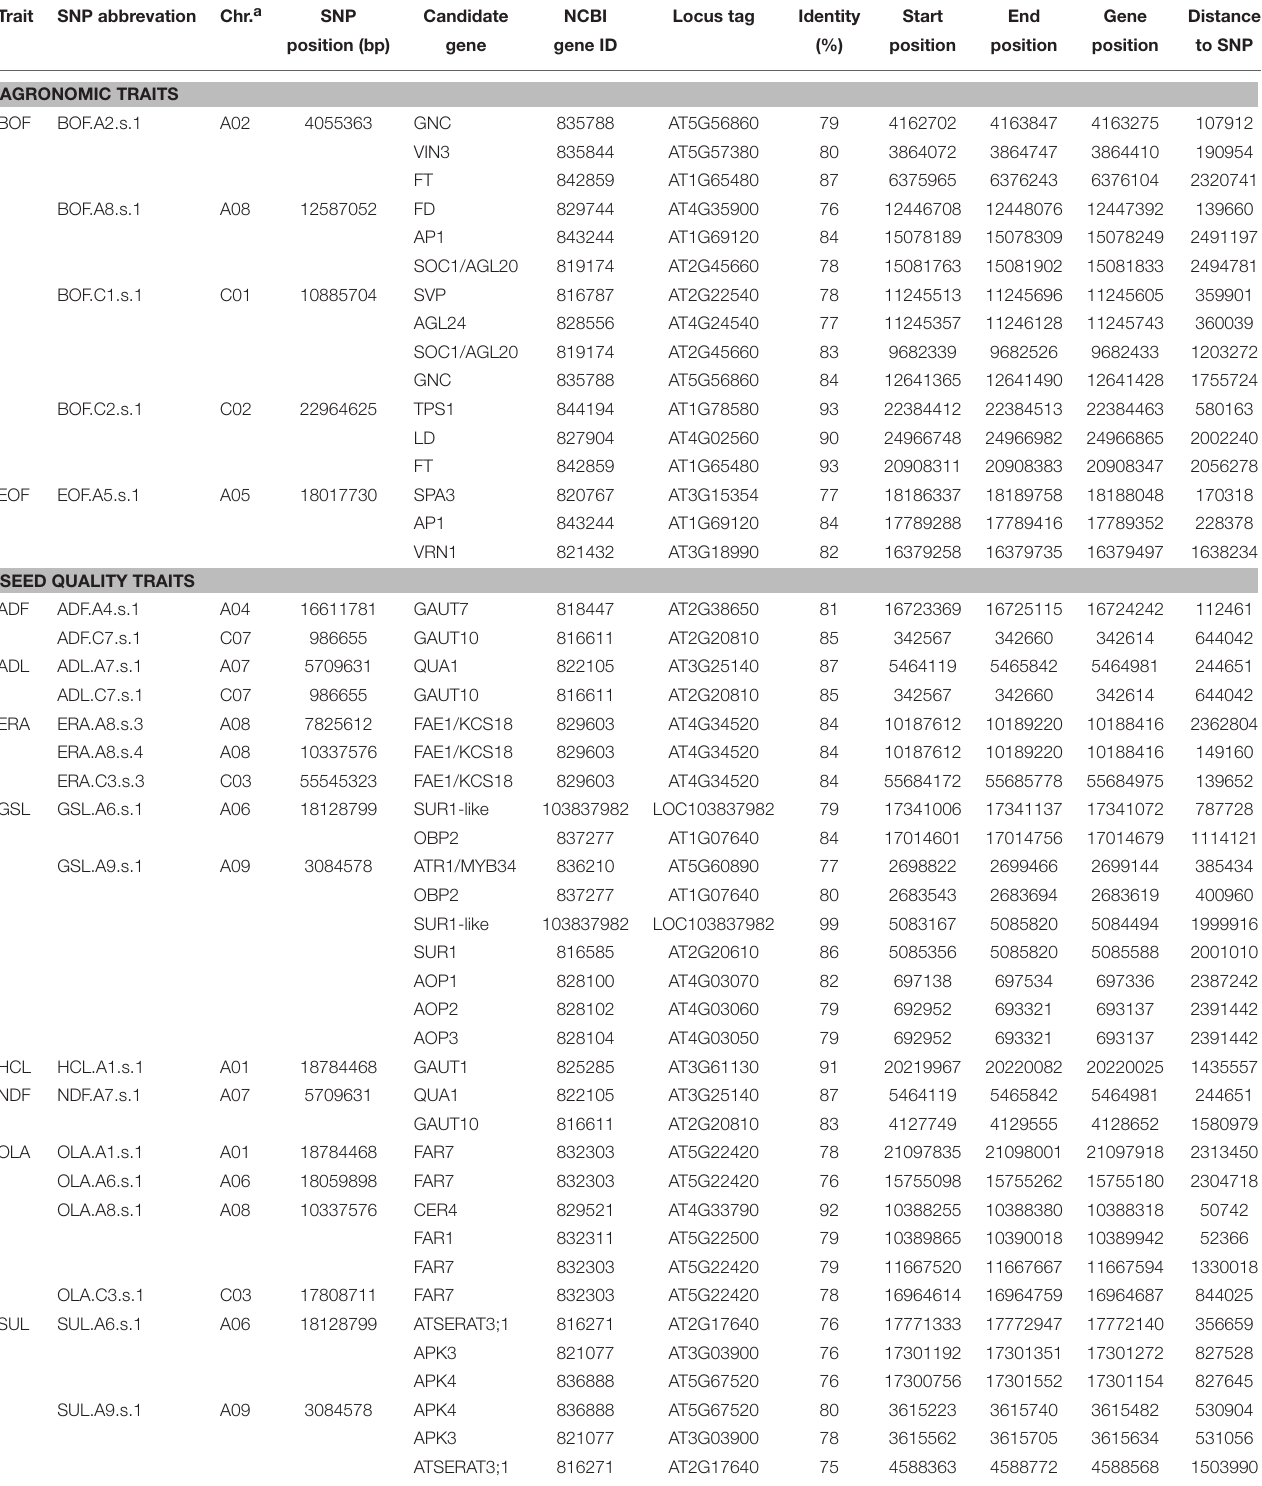
TABLE 4 | BLAST search results for pre-selected candidate genes for the single nucleotide polymorphism (SNP)-trait associations with P < 1.28e-05 (Bonferroni correction of α = 0.05) within a distance of 2.5 Mbp around the SNP-trait associations across the 184 inbreds of the spring trial. Trait SNP abbrevation Chr.